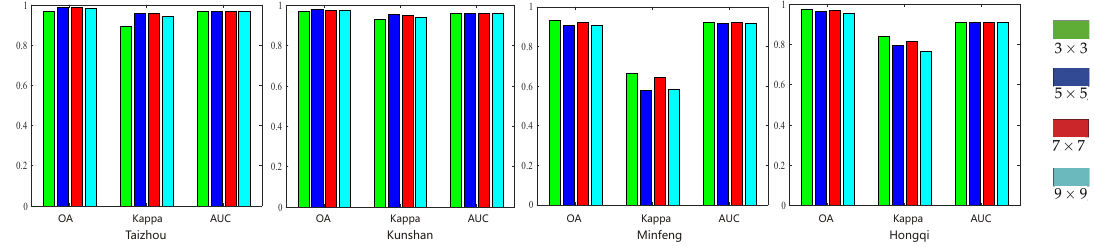
Figure 4. OA, Kappa and AUC values comparision of difference patch sizes on the four different data sets. Green, blue, red and sky blue colors denote patch size 3 × 3, 5 × 5, 7 × 7 and 9 × 9,